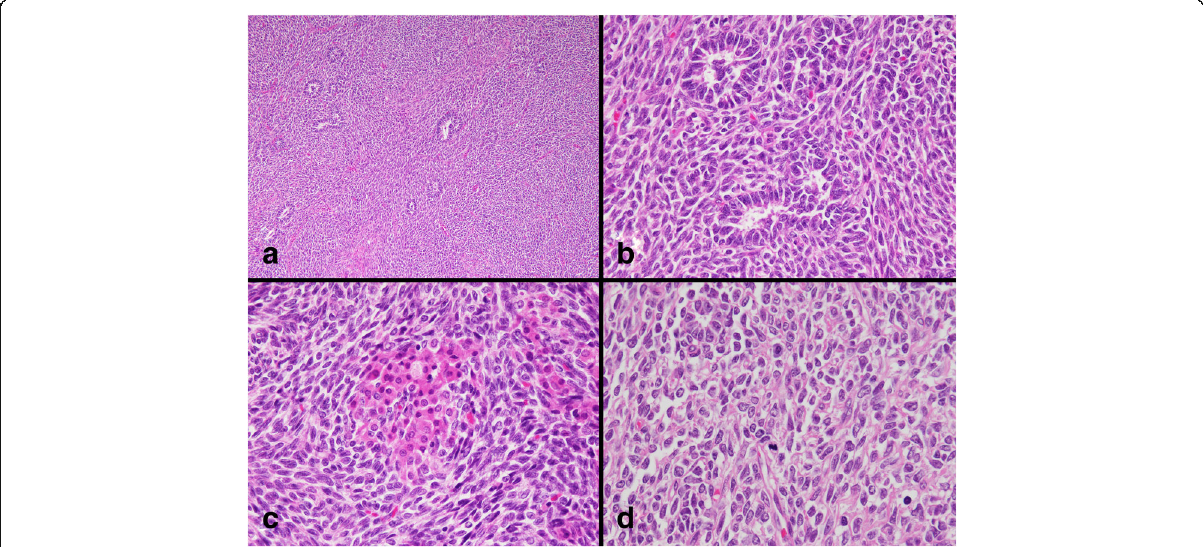
Fig. 3 Histopathological findings of the mesenteric tumor. a Low-power view. b Tubules consisted of Sertoli cell-like tall columnar cells. c Nests